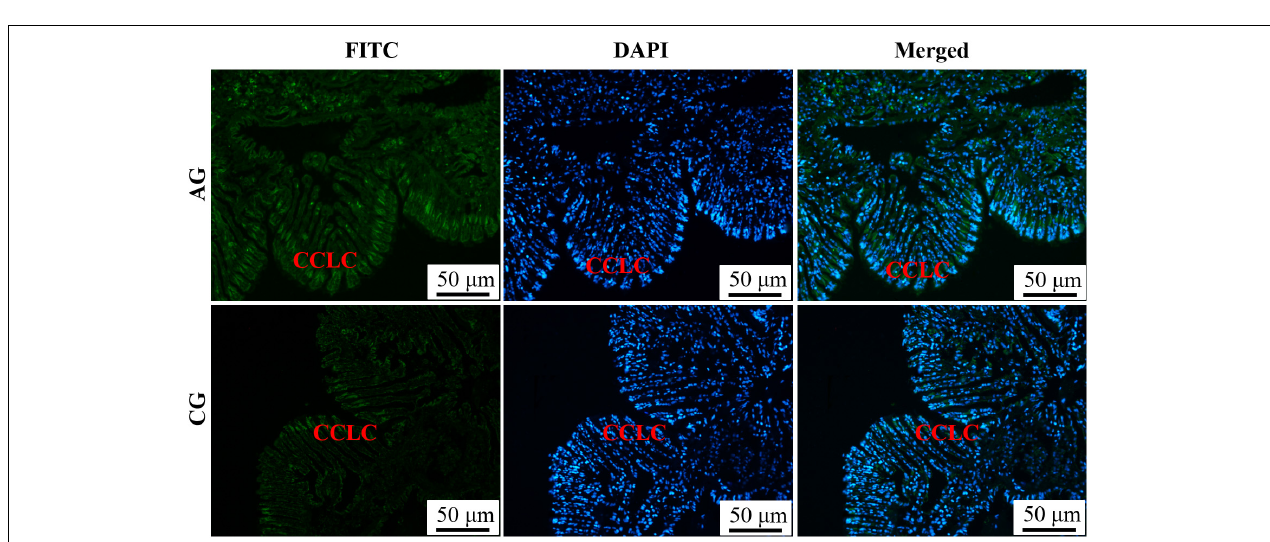
FIGURE 1 | Paraffin section observation of gills (A) and the hepatopancreas (B) in the Sinonovacula constricta . CCFC, columnar cells of frontal cilia; CCLC, columnar cells of lateral cilia; FC, flat cells; HS, hepatic sinusoid; EC, endothelial cells; H, hepatocytes. Scale bars were 50 µ m.